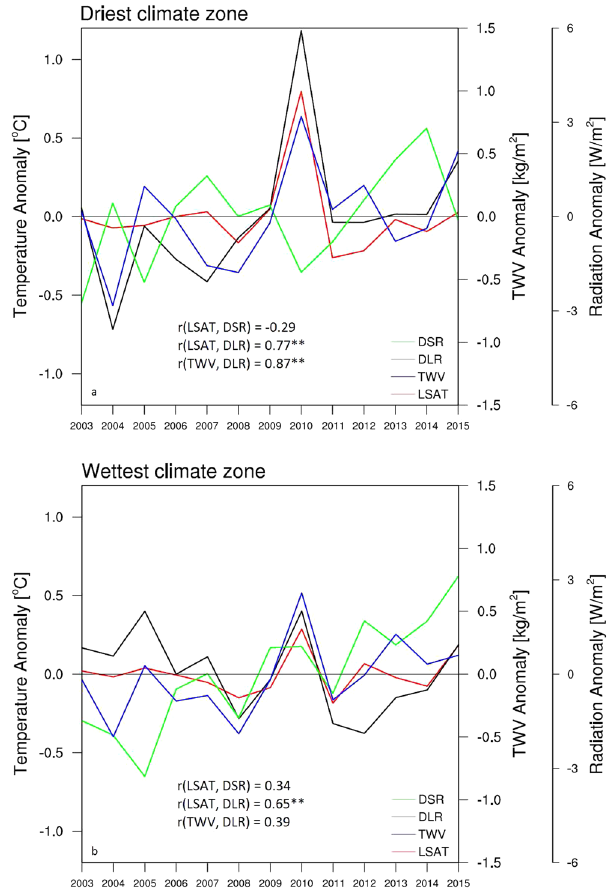
Figure 5. Zonal mean anomalies of LSAT (°C) and TWV (kg/m 2 ) from AIRS and DSR (W/m 2 ) and DLR (W/ m 2 ) from CERES-EBAF for the period 2003–2015 averaged over the ( a ) driest and ( b ) wettest from the 12 large-scale climate zones classified by precipitation. Correlation coefficients with “ ** ” are statistically significant (p <